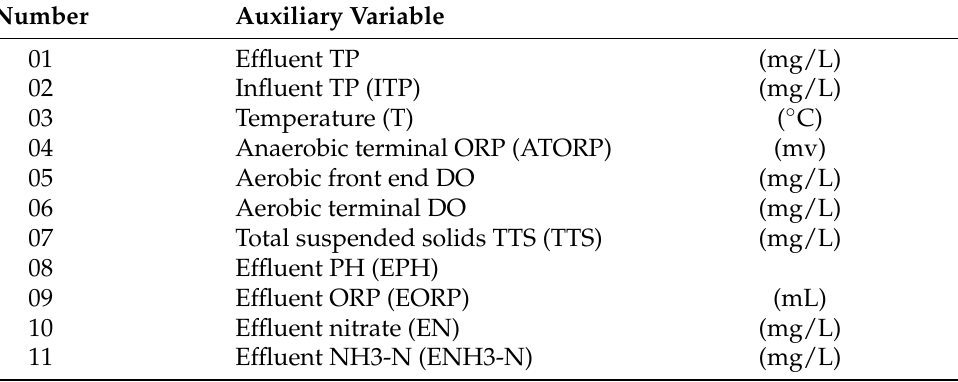
Table 2. Effluent NH3-N data